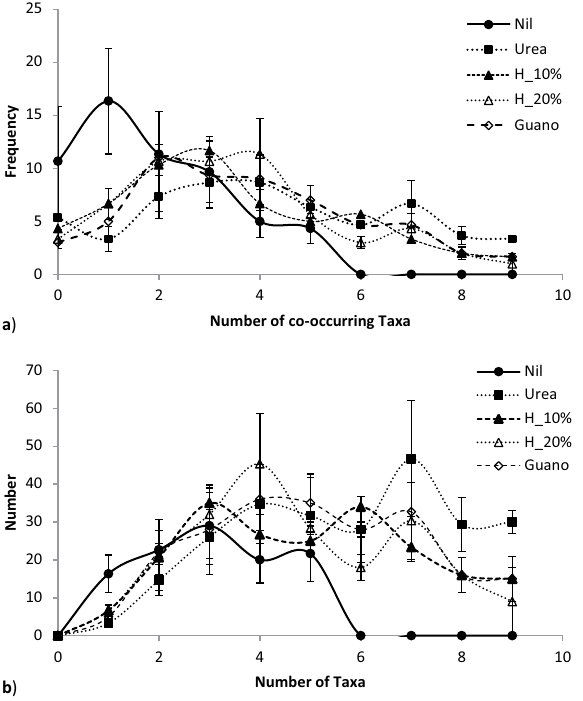
Figure 5. Effect of urea, urea plus humate (H) and urea plus humate and guano on ( a ) the number of co – occurring combined microbial taxa and ( b ) total number taxa per sample, mean ± standard